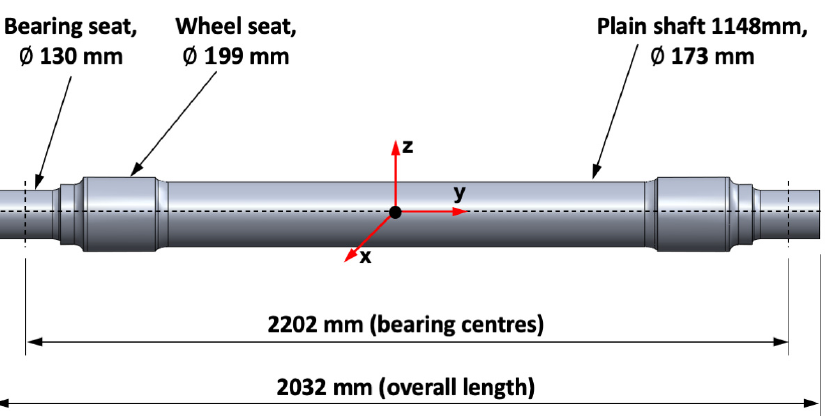
Figure 1. An outboard bearing trailer axle with typical dimensions illustrating the wheel seat, bearing seat and plain shaft region. The global coordinate system shown is in accordance with EN 131031-1.